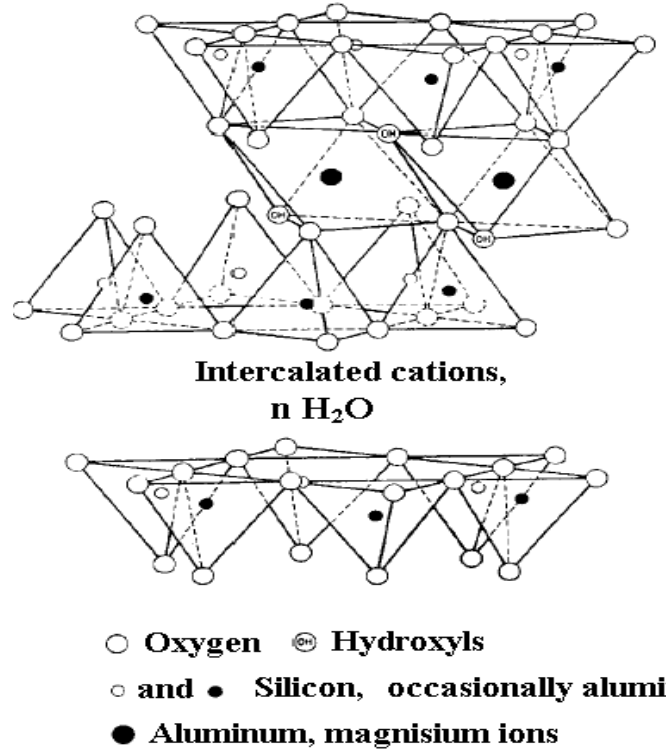
Figure 2. Schematic representation of montmorillonite clay.